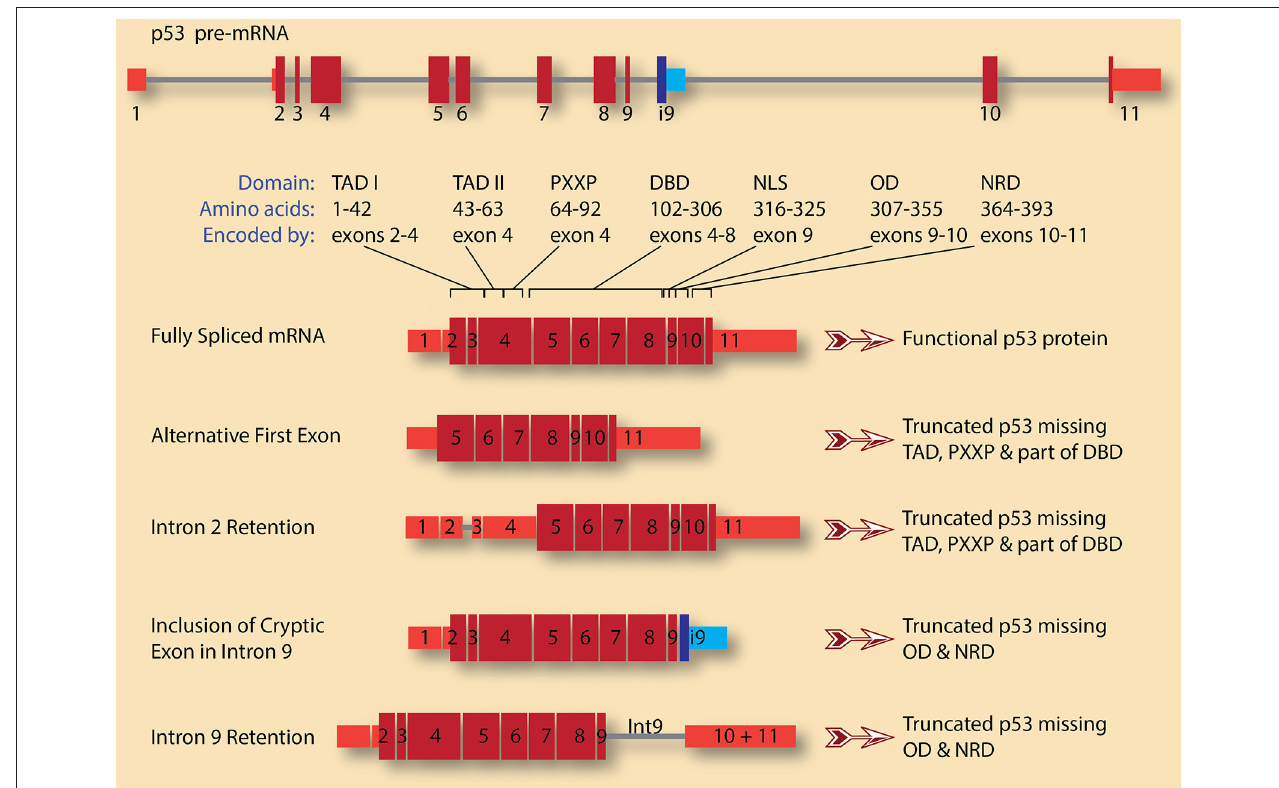
FIGURE 2 | TP53 pre-mRNA splicing has significant consequences on the gene product, p53 protein. A schematic diagram of p53 pre-mRNA shows 11 exons (red boxes for canonical exons and blue boxes for cryptic intronic exon 9, i9) and 10 introns (gray lines). The size and shade of the exon indicate whether it is untranslated region (narrow, light red) or coding (wide, dark red). The various domains and the exons encoding them are also indicated (adopted from Surget et al., 2013). These are: Transactivation domains I and II (TAD I and TAD II), proline-rich region (PXXP), DNA-binding domain (DBD), nuclear localization signal (NLS), oligomerization domain (OD), and negative regulation domain (NRD). A fully spliced mRNA containing the 11 canonical exons encodes for full length and functional p53 protein. Several isoforms with various alternative first exons can be generated for p53 pre-mRNA. In this case, the first exon is what is usually exon 5 in the canonical transcript, leading to the production of p53 protein lacking TADs, PXXP, and part of DBD. This truncated p53 is expected to be dominant negative. A similar protein can be encoded by transcripts in which intron 2 is retained, leading to the usage of start codon in exon 4 rather than the canonical start codon in exon 2. On the other hand, retention